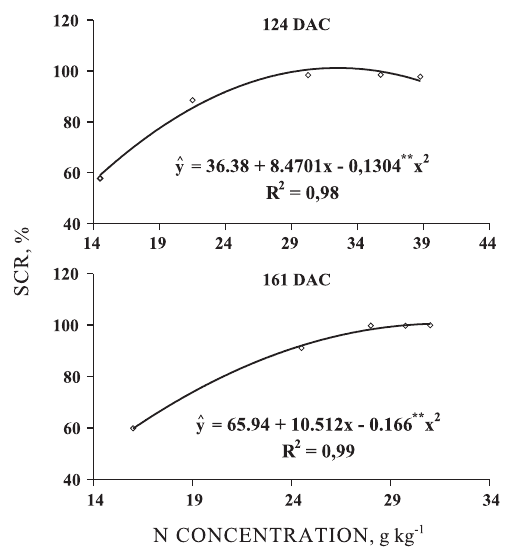
Figure 7. Soil cover rate in relation to the N concentration in Bermuda grass leaf blades 124 and 161 days after cutting.